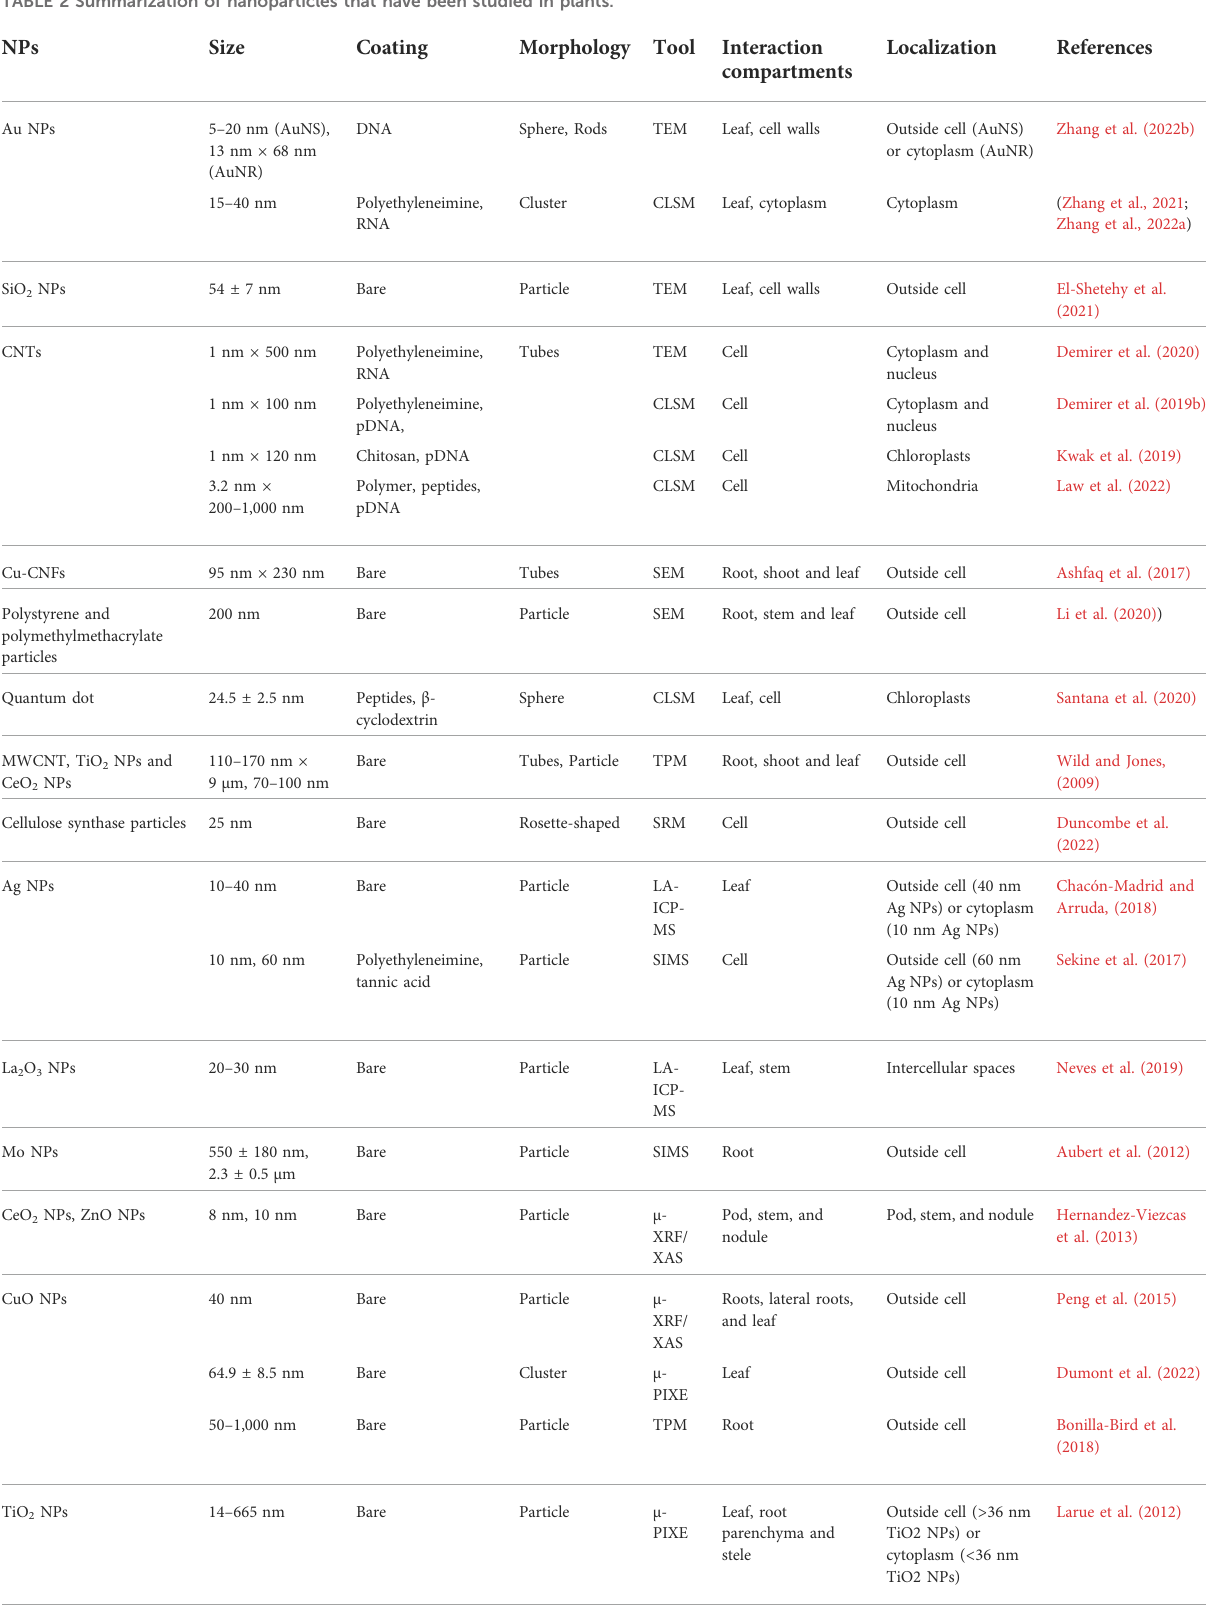
TABLE 2 Summarization of nanoparticles that have been studied in